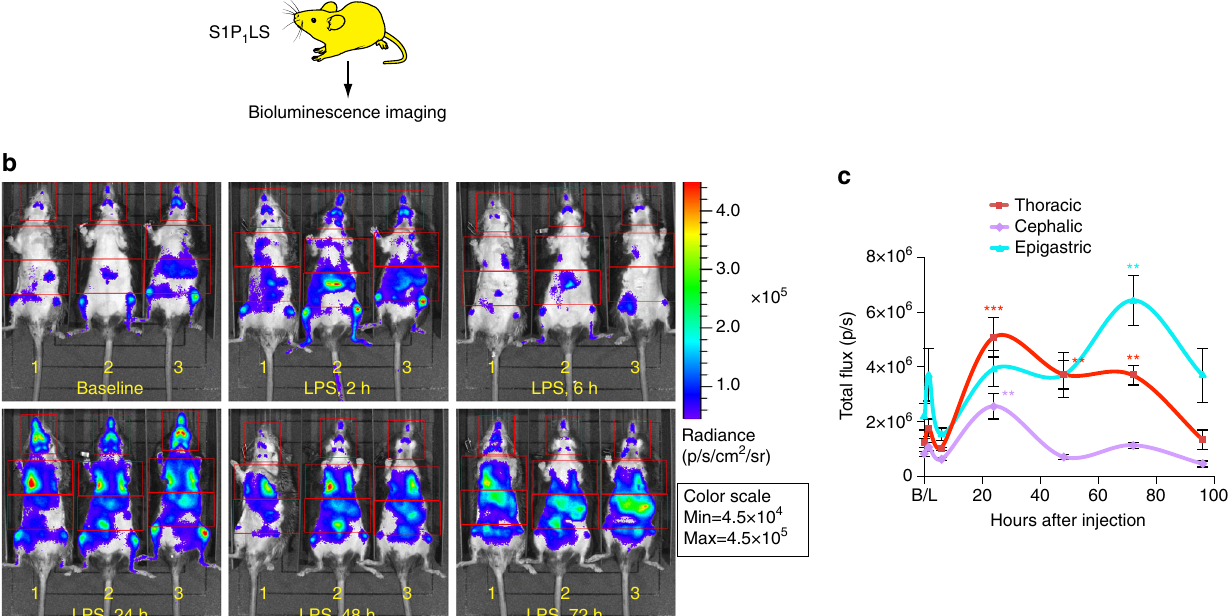
Fig. 4 S1P 1 activation during LPS-induced systemic in fl ammation in live mice. a S1P 1 luciferase signaling (S1P 1 LS) mice were injected intraperitoneally with LPS to induce systemic in fl ammation, then subjected to BLI. b Representative bioluminescence images of the same three mice prior to LPS injection (baseline, B/L) and 2, 6, 24, 48, and 72 h after LPS injection. Mice were imaged in the supine position. Red open rectangles representing ROI were positioned around cephalic, thoracic, and epigastric regions. c The bioluminescence activity was quanti fi ed by determining the total fl ux (photons/sec; p/ sec) in each ROI. Data represent the mean ± SEM. n = 5. P values were determined between baseline and each time point by one-way ANOVA followed by Bonferroni ’ s multiple comparisons test; ** P ≤ 0.01, *** P ≤